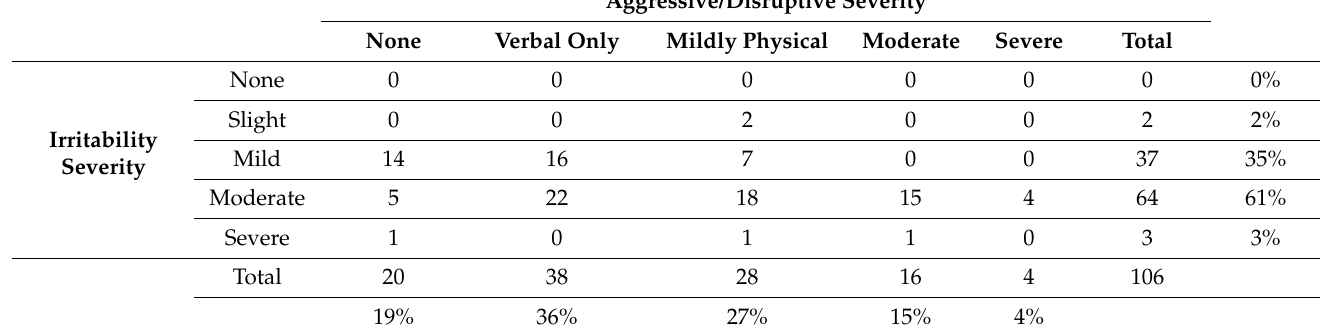
The number of patients classified by severity of UHDRS Irritability and Aggres- sive/Disruptive